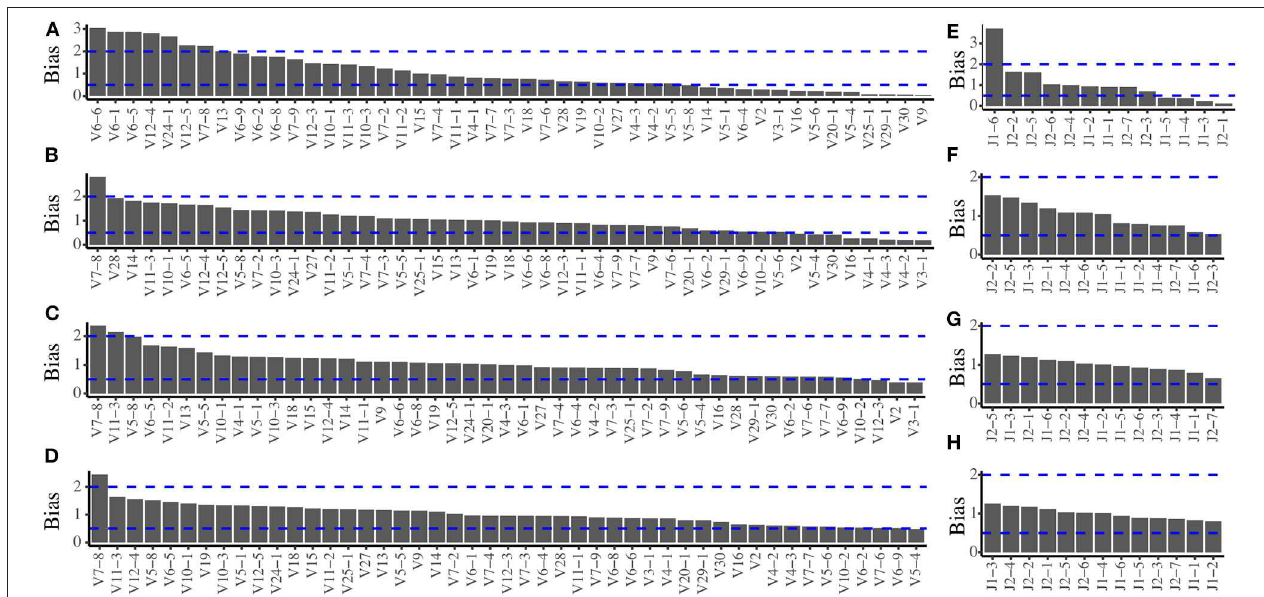
FIGURE 1 | Amplification bias of the multiplex PCR reaction system during primer mix optimization for pool 1. (A) The TRBV amplification bias before optimization. (B,C) The TRBV amplification bias during optimization. (D) The TRBV amplification bias after optimization. (E) The TRBJ amplification bias before optimization.